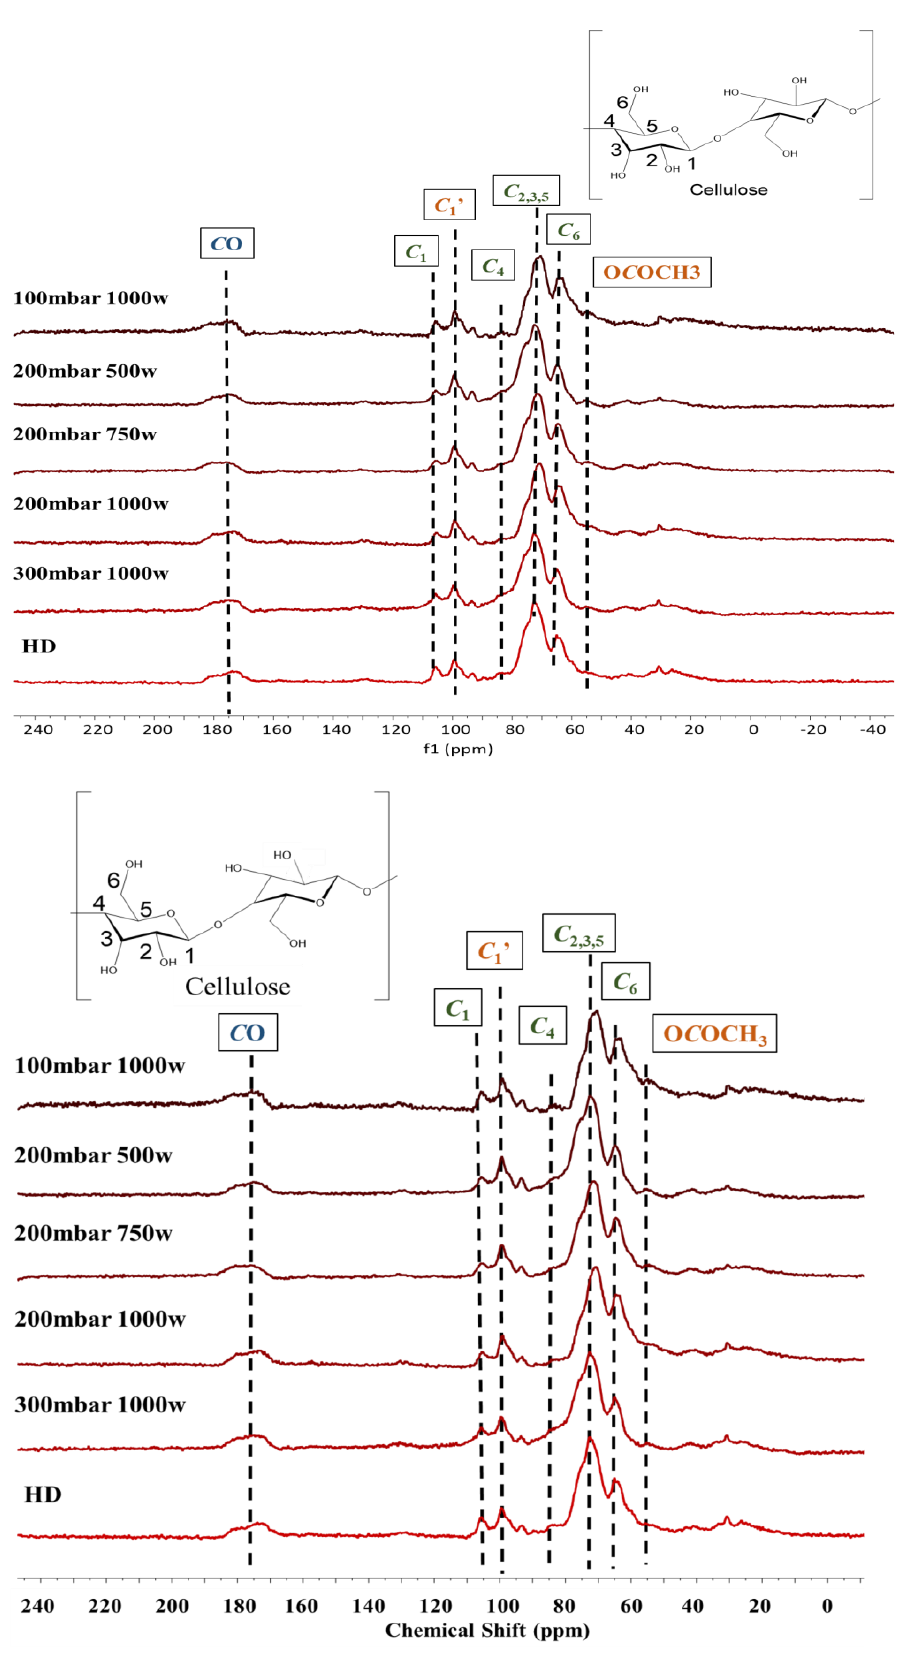
Figure 3. 13 C CP/MAS NMR spectra of cucumber residues obtained from HD and VMHDF.